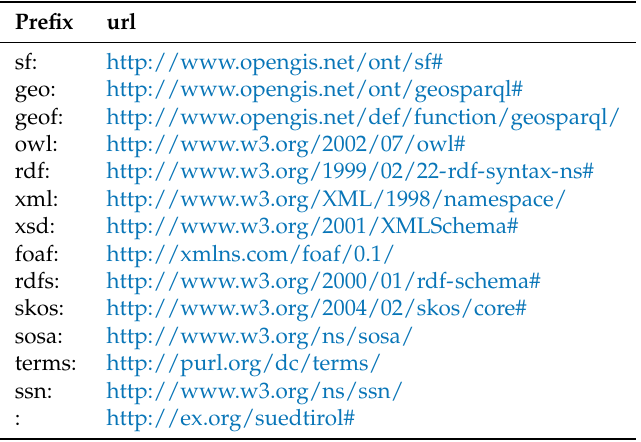
Table 2. Prefixes in the